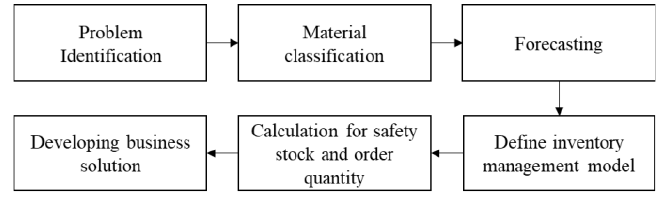
Figure 2: Research Conceptual